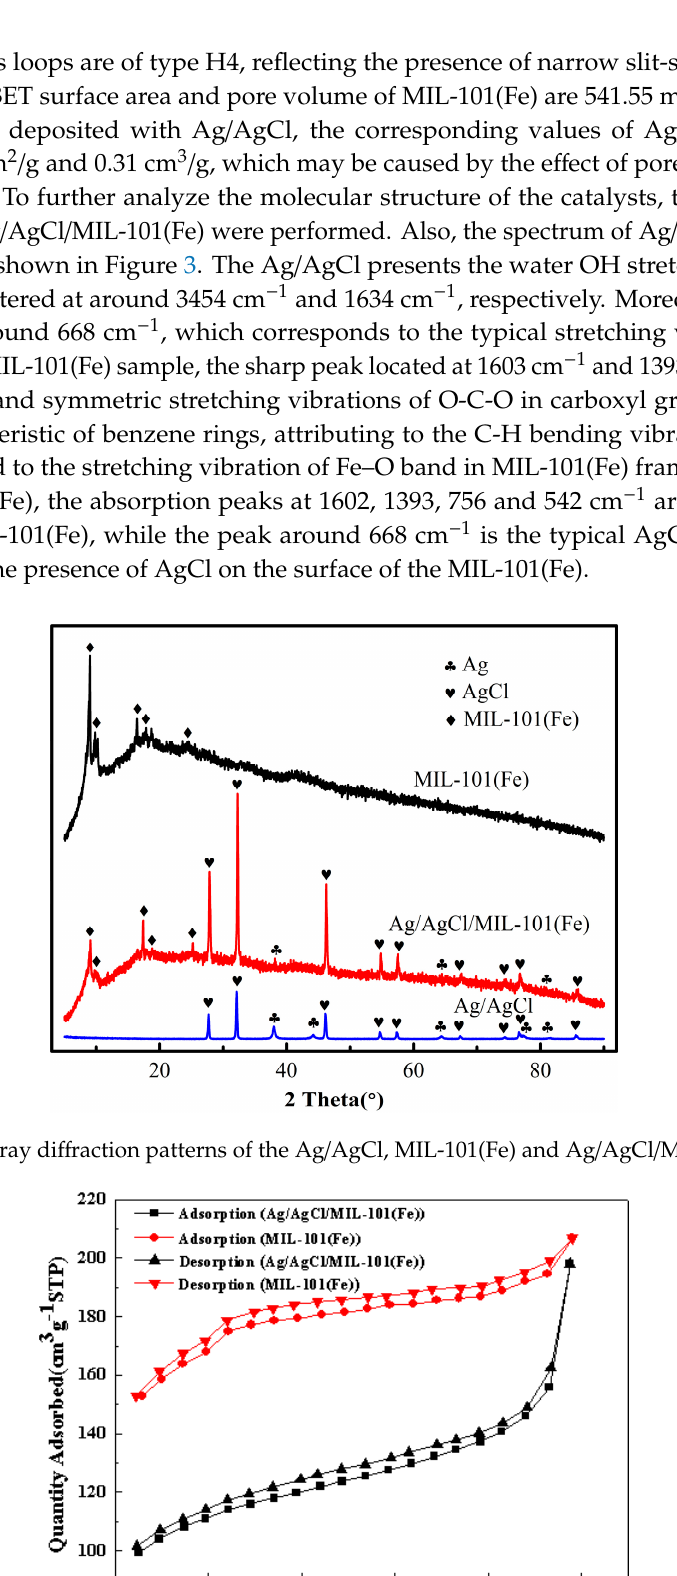
Figure 2. Nitrogen adsorption ‐ desorption isotherms of MIL ‐ 101(Fe) and Ag/AgCl/MIL ‐ 101(Fe).